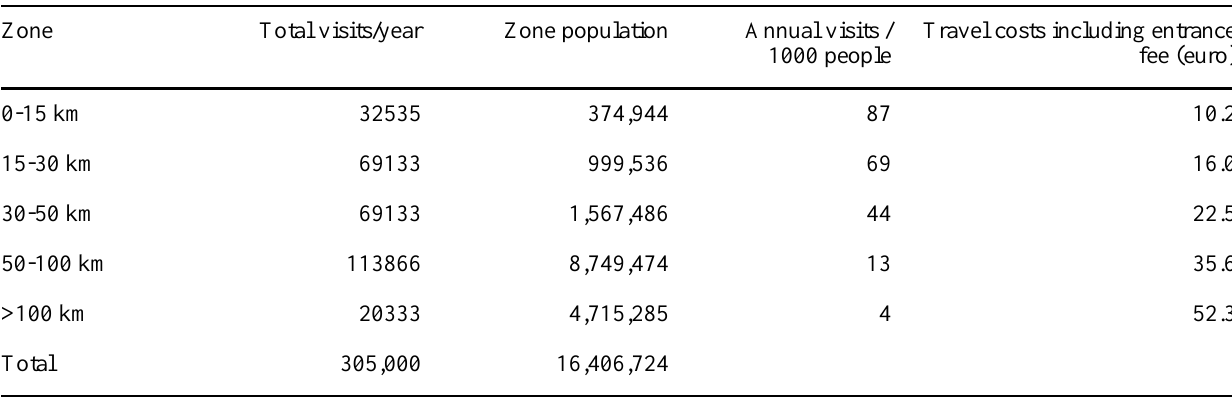
Table 3 . Visitor rates and travel costs to the Hoge Veluwe